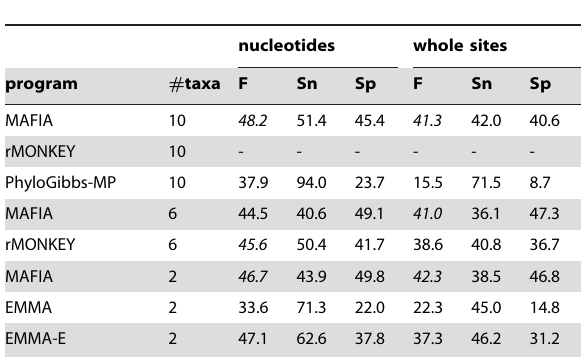
PLoS Computational Biology |